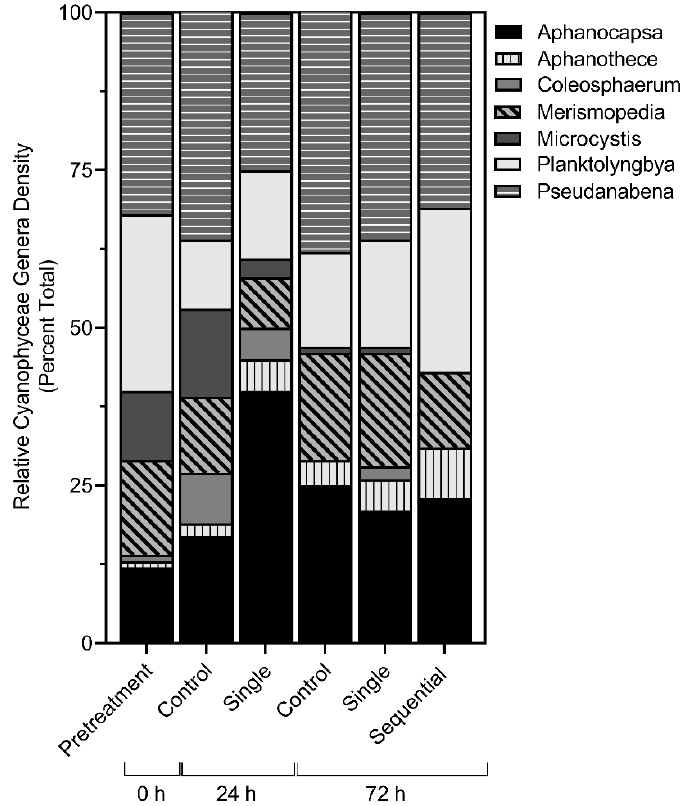
Figure 6. Cyanobacterial community composition. Relative cyanophycean concentration per sample broken down by major genus: Aphanocapsa (black), Aphanothece (light gray with black vertical stripes), Coelosphaerium (medium gray), Merismopedia (medium gray with black angled stripes), Microcystis (dark gray), Planktolyngbya (light gray), Pseudanabaena (dark gray with white horizontal stripes). Bars represent the average cell density for each genus ( n = 3).